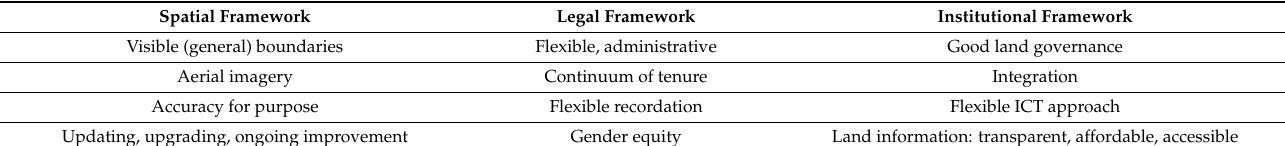
Table 2. The key principles of a fit-for-purpose approach to land administration [13]. Spatial Framework Legal Framework Institutional